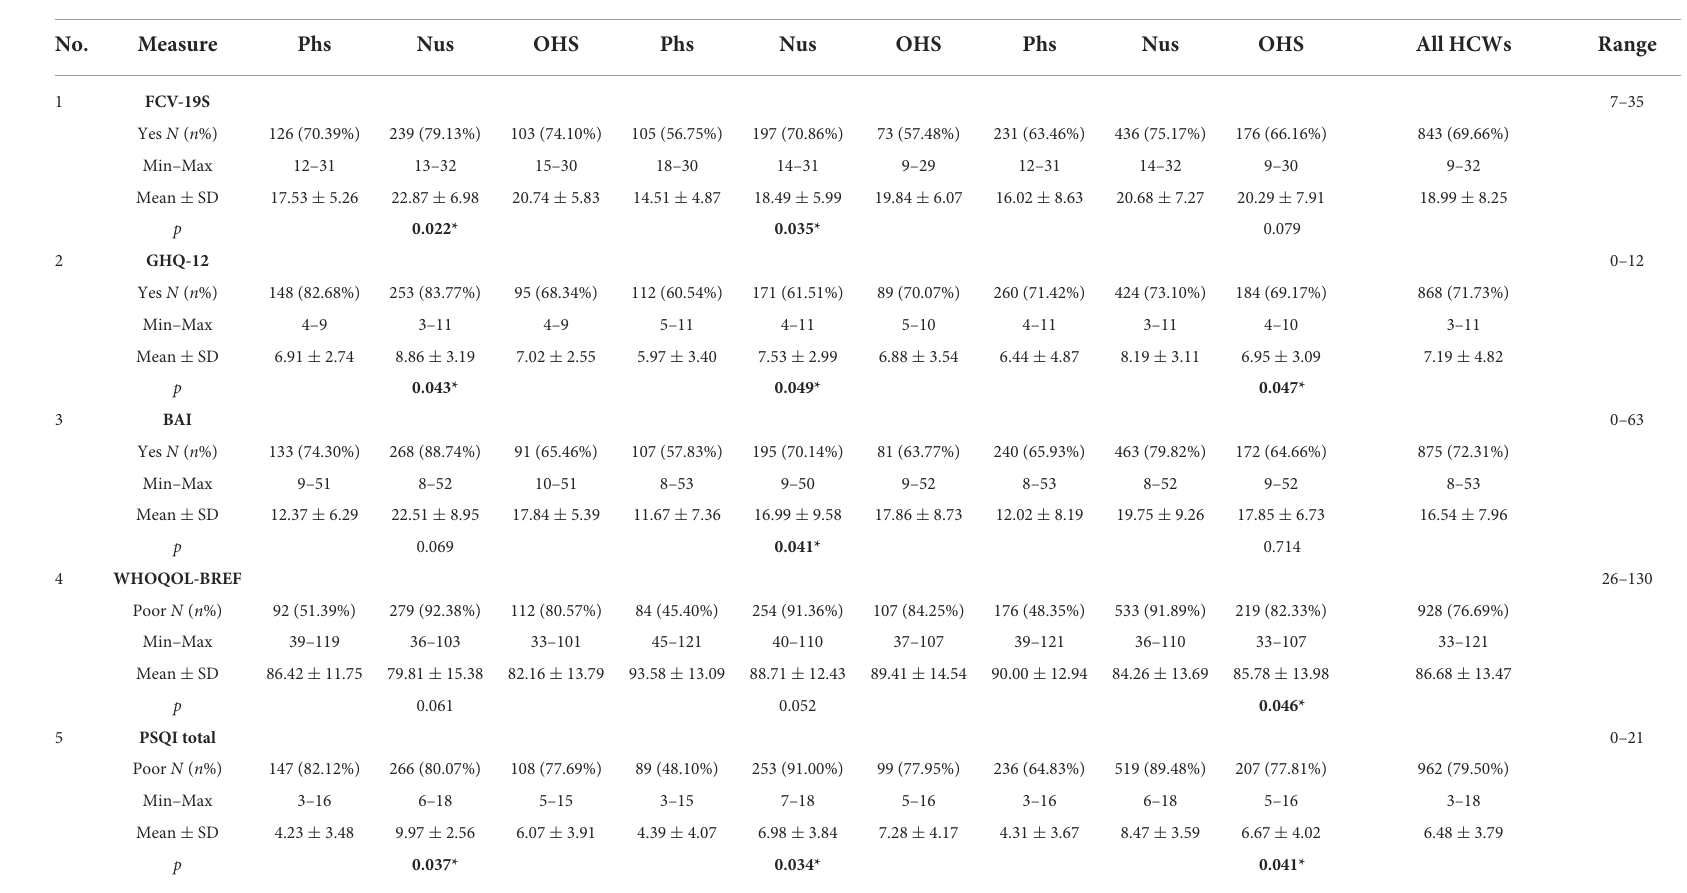
TABLE 3 Prevalence of psychological distress, anxiety, the level of quality of life, and sleep problems among HCWs from Iran and the European countries. Iran Studied European countries Full sample (Iran and the studied European